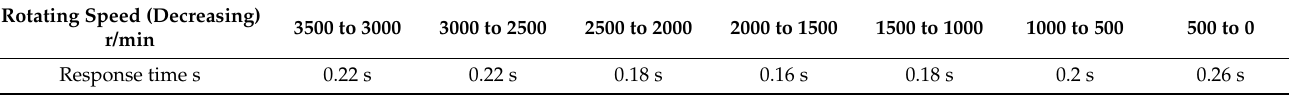
Table 6. Response test of dc motor speed decline of single fertilizer apparatus.